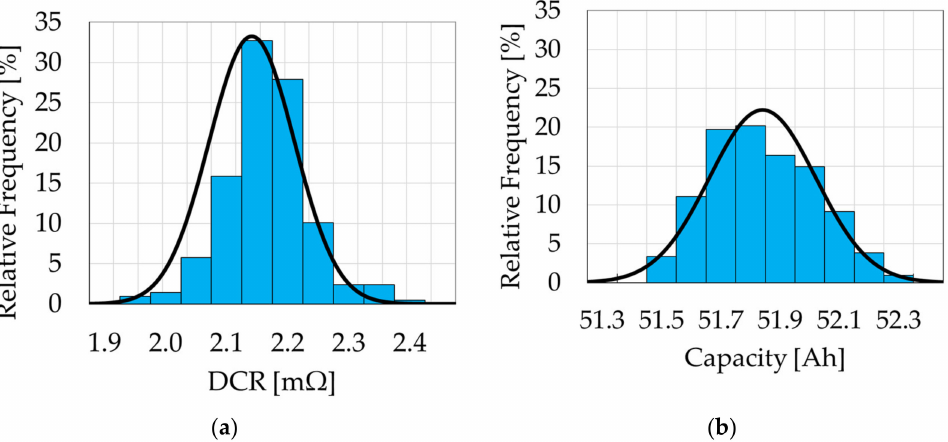
Figure 10. Histograms and normal distributions of the relative frequency of ( a ) the DCR and ( b ) the 1C discharge capacity for 208 Kokam SLPB 53 Ah lithium-ion pouch cells at BOL